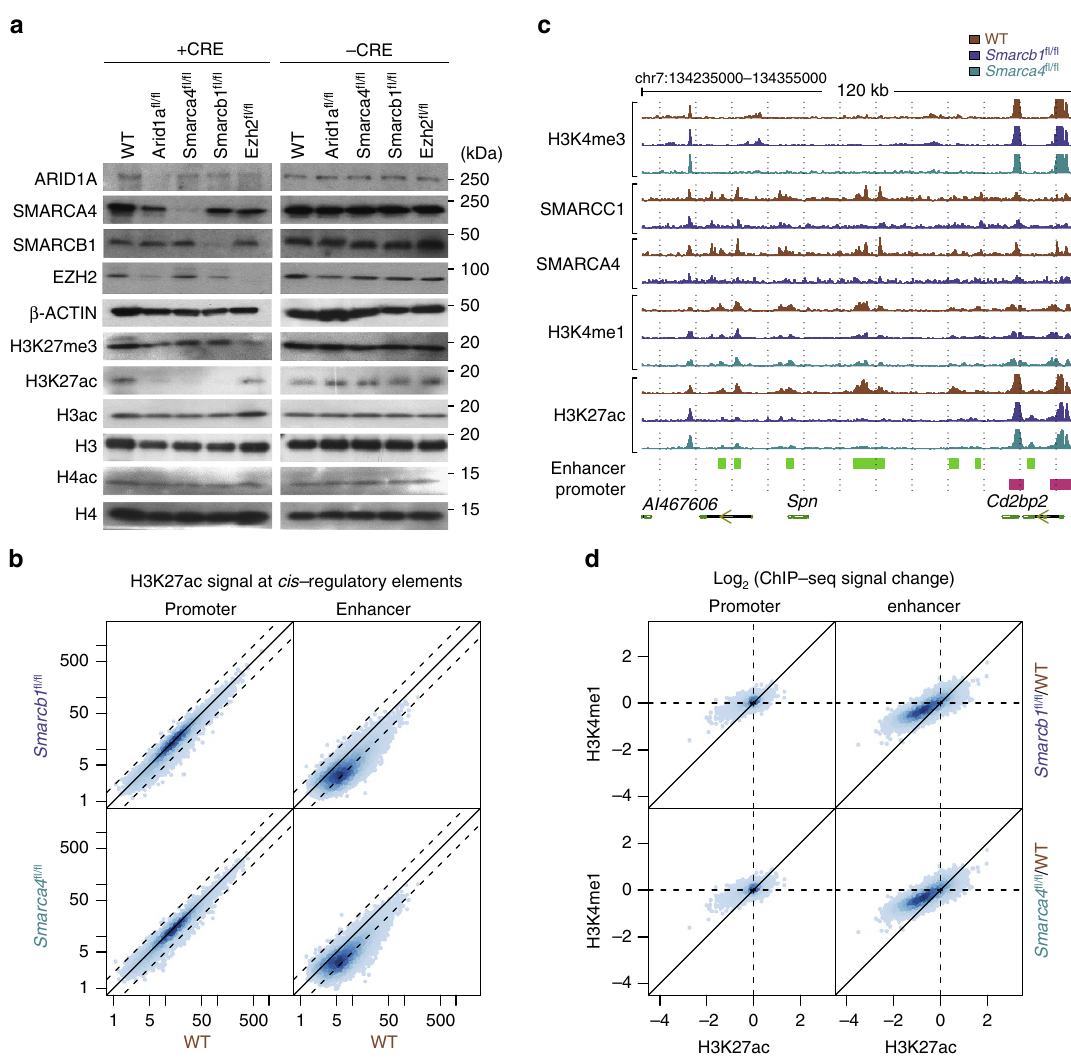
Figure 1 | Deletion of SWI/SNF subunits results in H3K27ac loss and enhancer deactivation. ( a ) Western blots of selected factors, histones and histone modifications in control MEFs (-CRE) and MEFs with CRE-inactivated SWI/SNF ( Arid1a , Smarca4 , Smarcb1 ) or Polycomb ( Ezh2 ) subunits. ( b ). H3K27ac signal at promoters and enhancers in Smarcb1 -deficient or Smarca4 -deficient versus wild-type MEFs. ( c ). Representative screenshot showing localization of subunits SMARCC1 and SMARCA4 and histone marks H3K4me3, H3K4me1 and H3K27Ac in wild-type, Smarcb1 -deficient and Smarca4 -deficient MEFs showing lost enhancers. ( d ) Log-fold changes of histone modifications H3K4me1 versus H3K27ac at promoters and enhancers in Smarcb1 -deficient or Smarca4 -deficient relative to wild-type